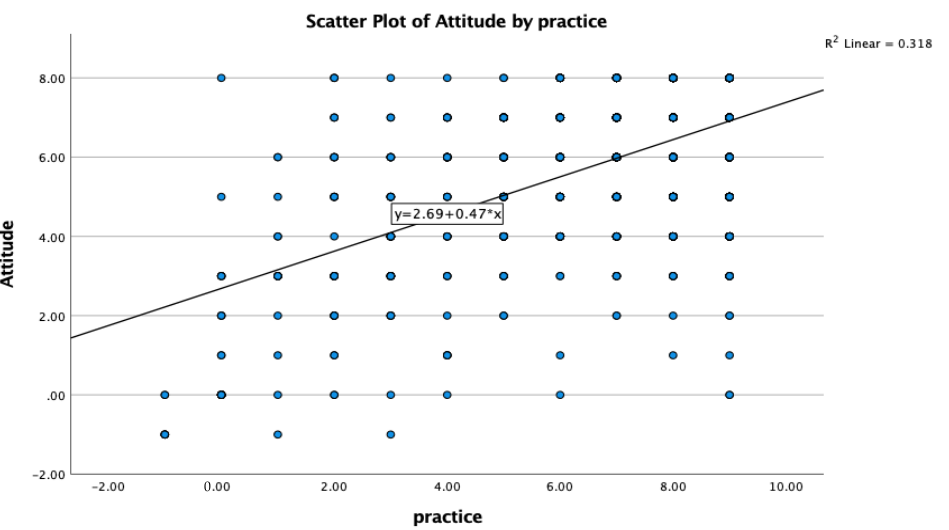
Figure 3. A positive association was observed between the attitude and practice of the surveyed